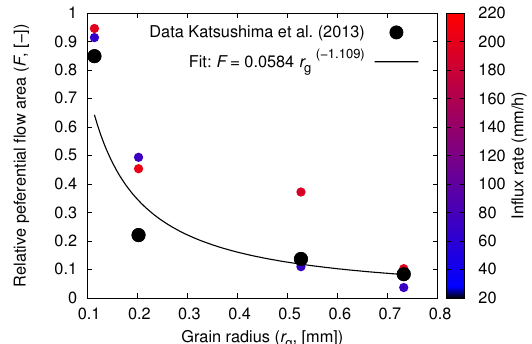
Figure 2. Relationship of the area involved in preferential flow as a function of grain radius. Data points represent laboratory experi- ments by Katsushima et al. (2013), presented quantitatively by Hi- rashima et al. (2014). Data points are coloured based on the water influx rate used in the experiments. The large black dots denote the data points used for determining the fit (solid line), corresponding to the lowest influx rate per grain size